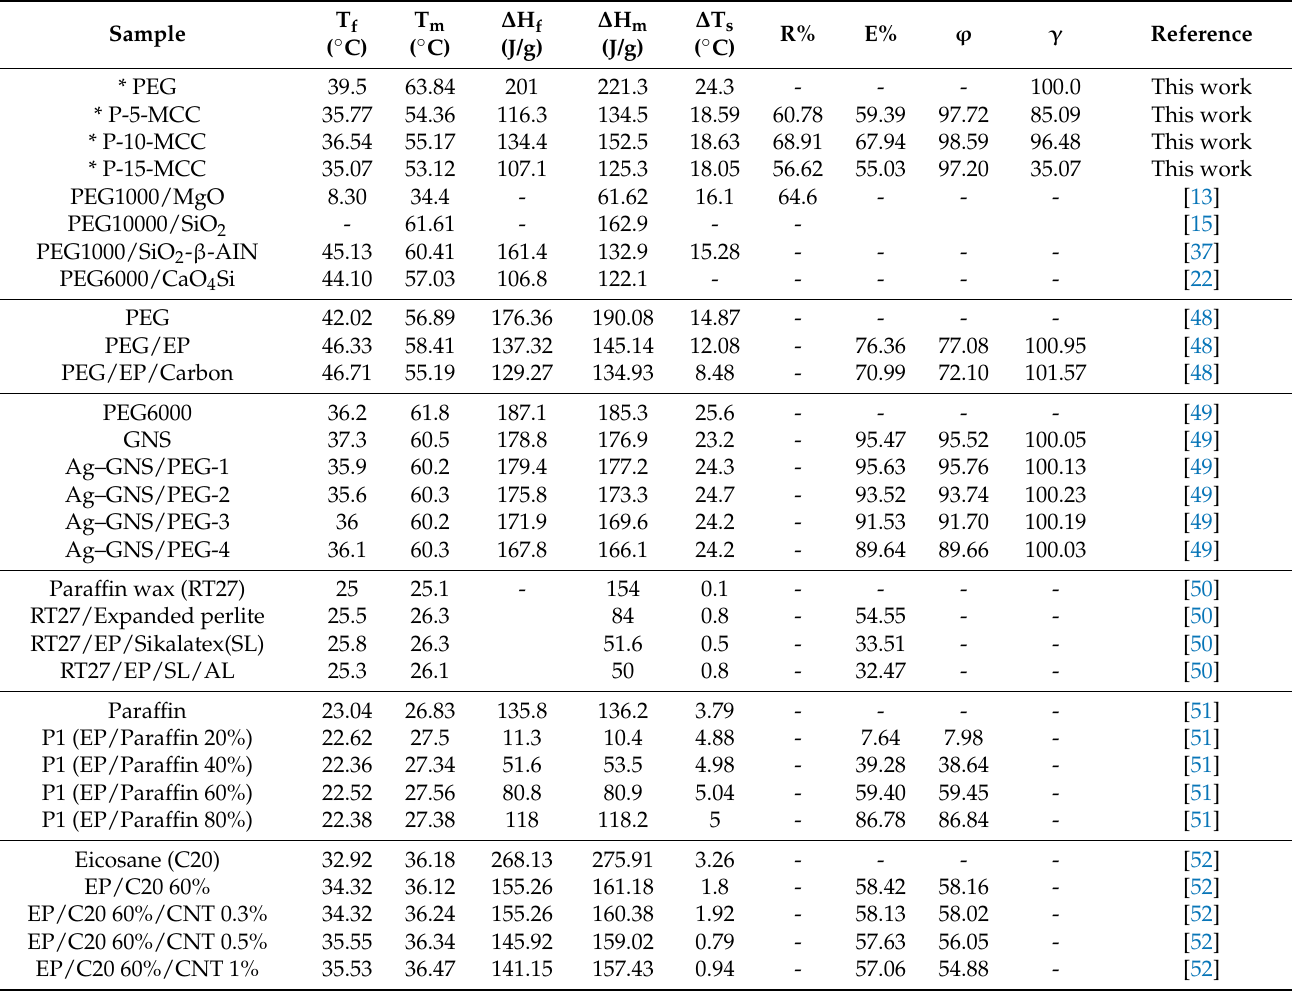
Table 1. DSC results of pure PEG-6000 (PEG) and PEG/5MgCaCO 3 , PEG/10MgCaCO 3 , and PEG/15MgCaCO 3 composite PCMs and comparison with those of different PEG composite PCMs reported in the